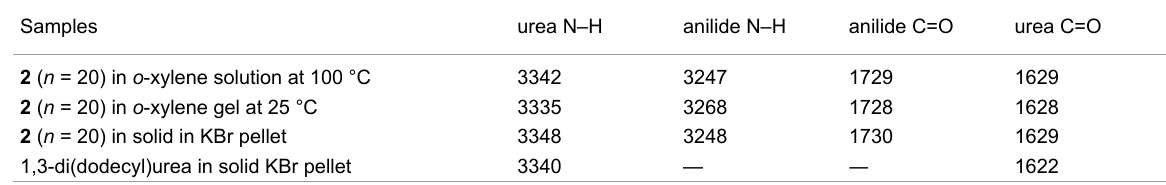
Table 3: FT-IR data of compound 2 ( n = 20) and 1,3-di(dodecyl)urea a .